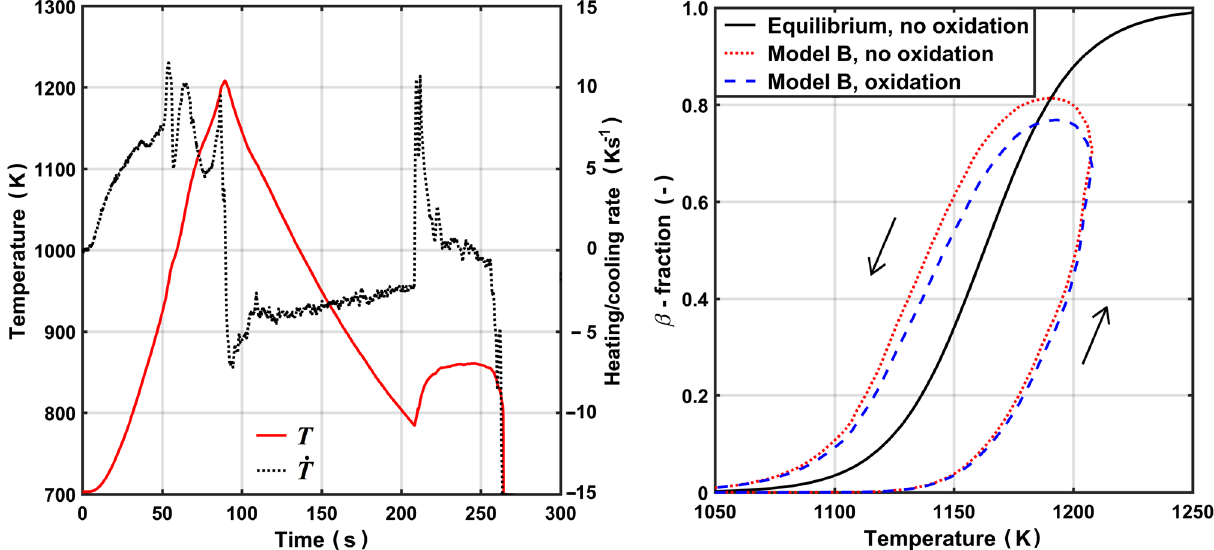
Figure 9. Left panel: Measured temperature history from the QUENCH-L1 LOCA test considered in calculations. Right panel: Calculated β -fraction in Zircaloy-4 cladding for the simulated temperature